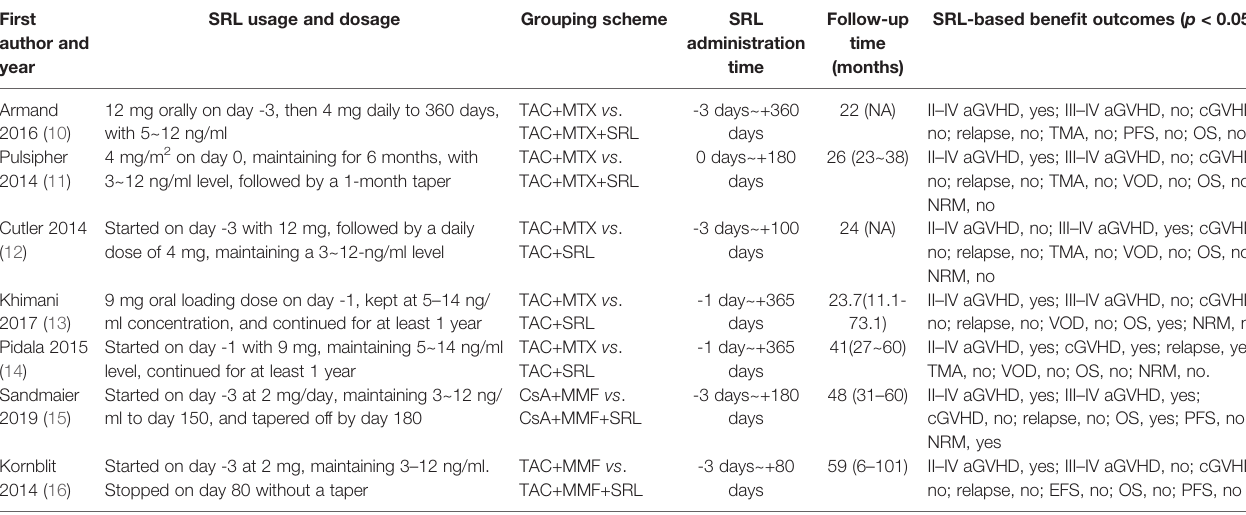
TABLE 2 | Characteristics of the included RCTs, comparing the SRL-based and non – SRL-based